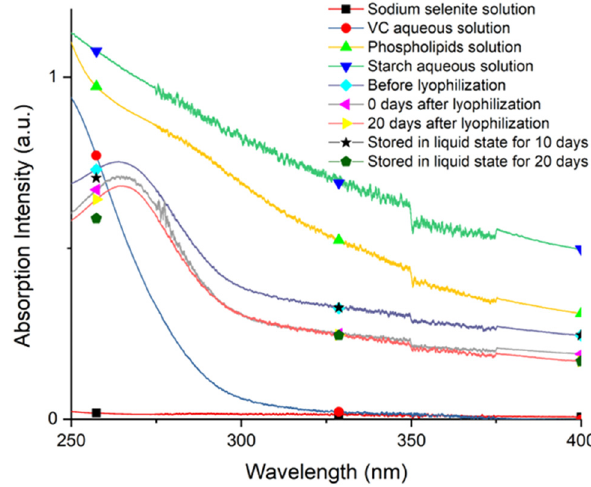
Figure 5: UV absorption curves of various